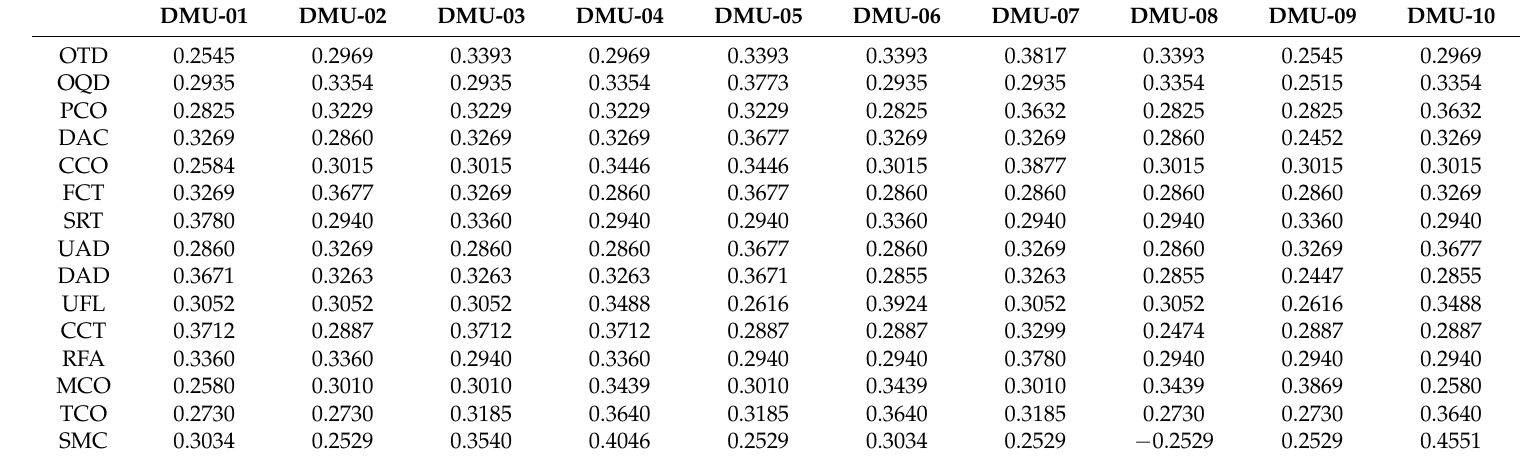
Table 6. Normalized matrix.